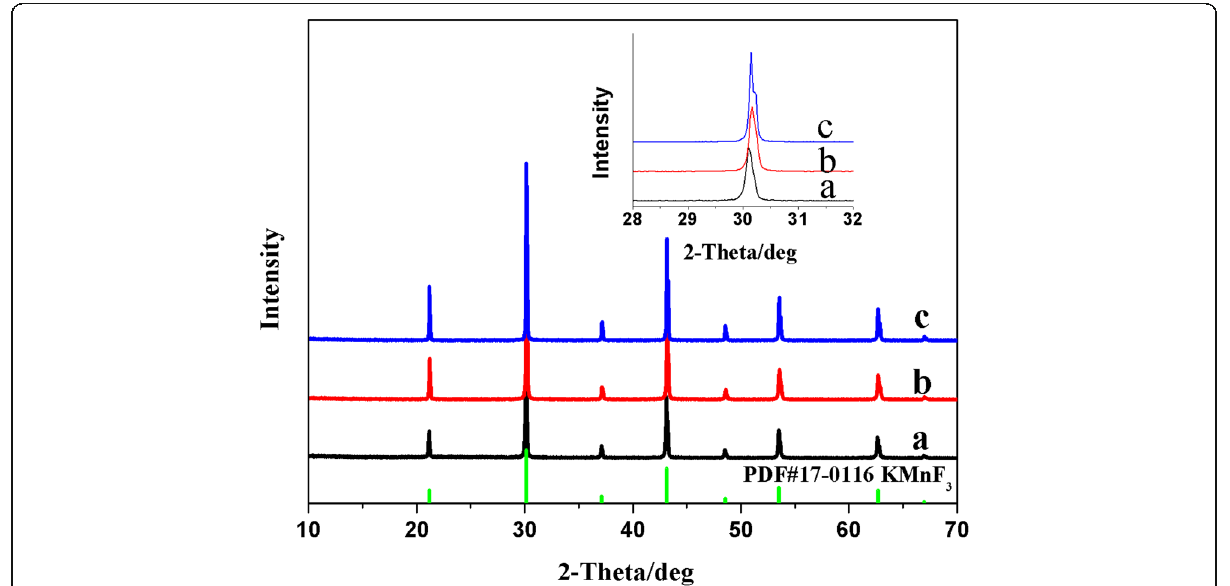
Fig. 1 The XRD patterns of KMnF 3 (a), K(Mn 0.975 Ni 0.025 )F 3 (b), and K(Mn 0.95 Ni 0.05 )F 3 (c) corresponding to different nickel acetate additions (a, b, and c represent the corresponding products when the addition of nickel acetate were 6.0mmol, 6.25 mmol, and 6.5mmol,